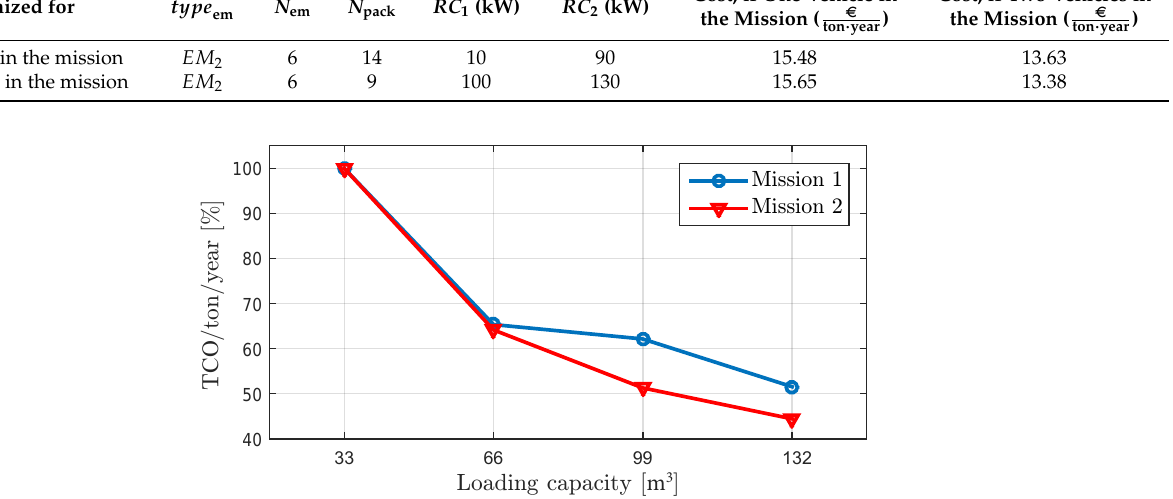
Table 4. Two optimum types of electric vehicles assigned to mission X 1 r for fully loaded vehicles and two trips per day. Optimized for